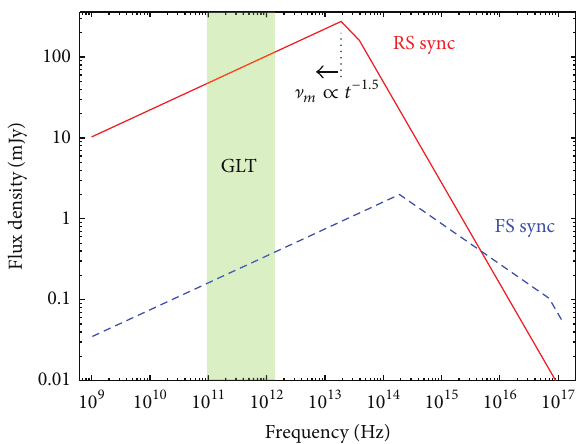
= 0.3 , 𝜖 = 0.03 , and 𝑒 𝐵, RS